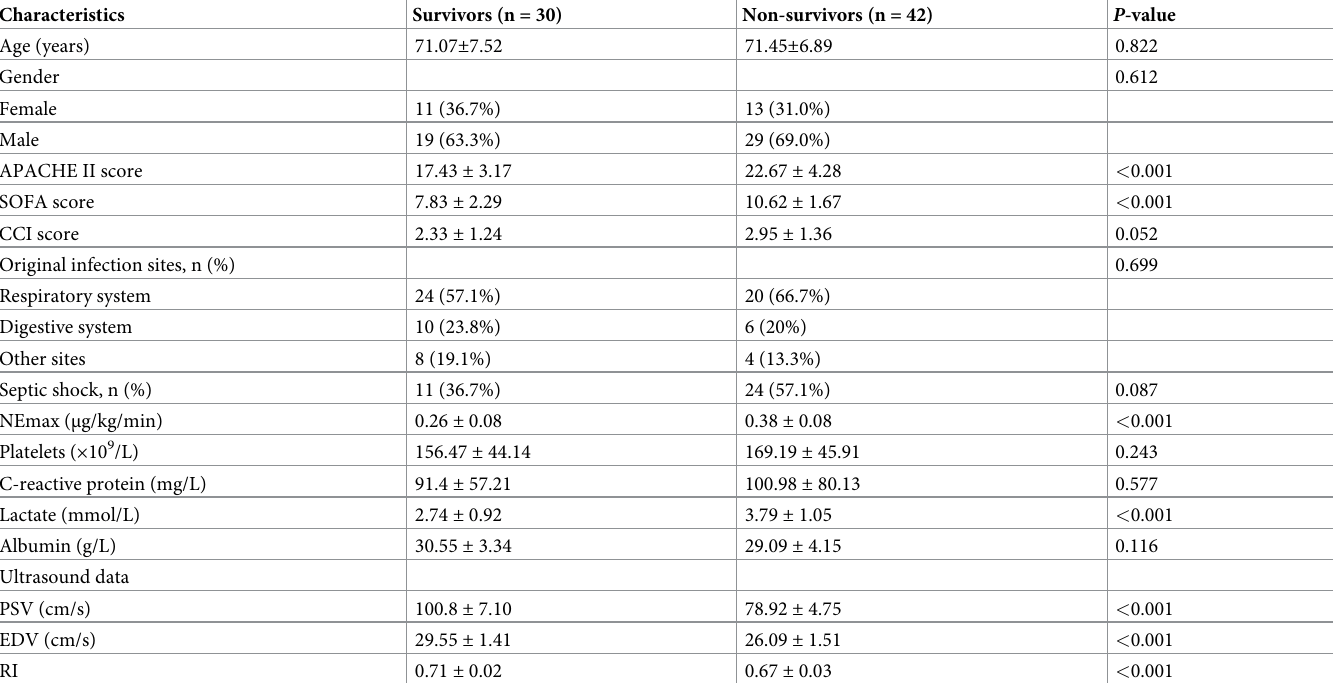
Table 1. Characteristics of septic patients (n = 72).